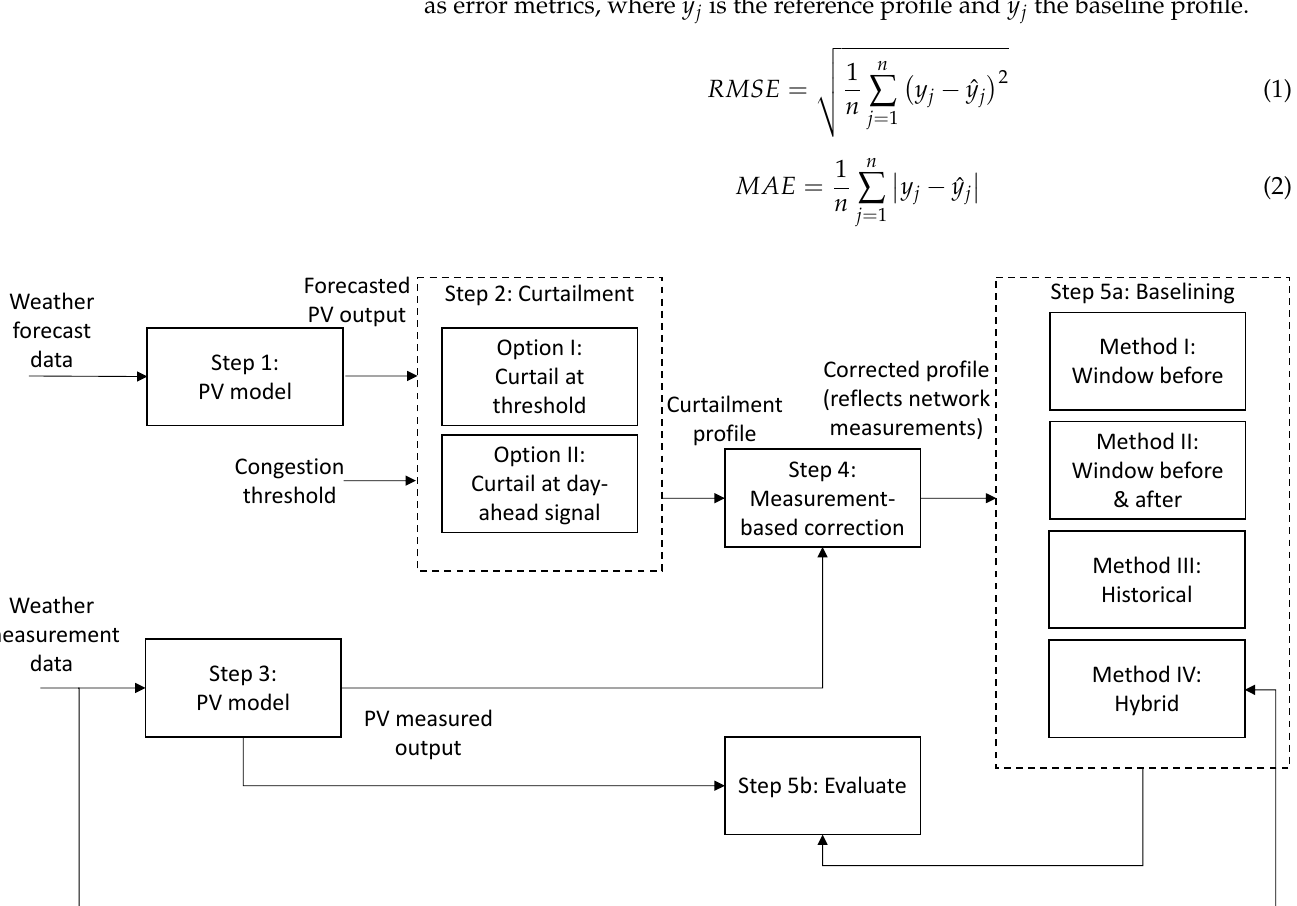
Figure 2. Overview of the implementation flow of the different baselining